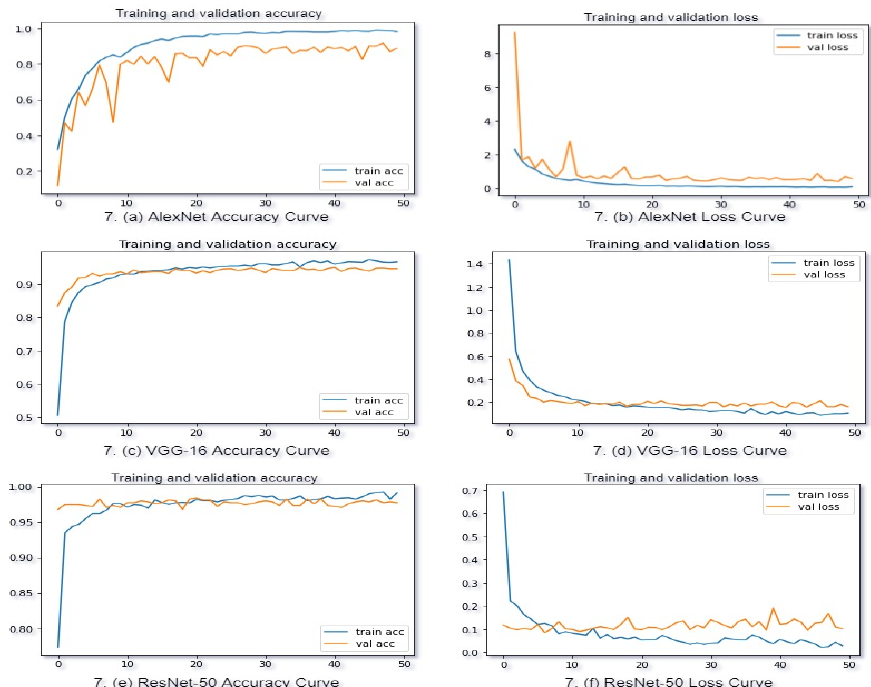
Figure 9. Accuracy and loss curve for training and validation.